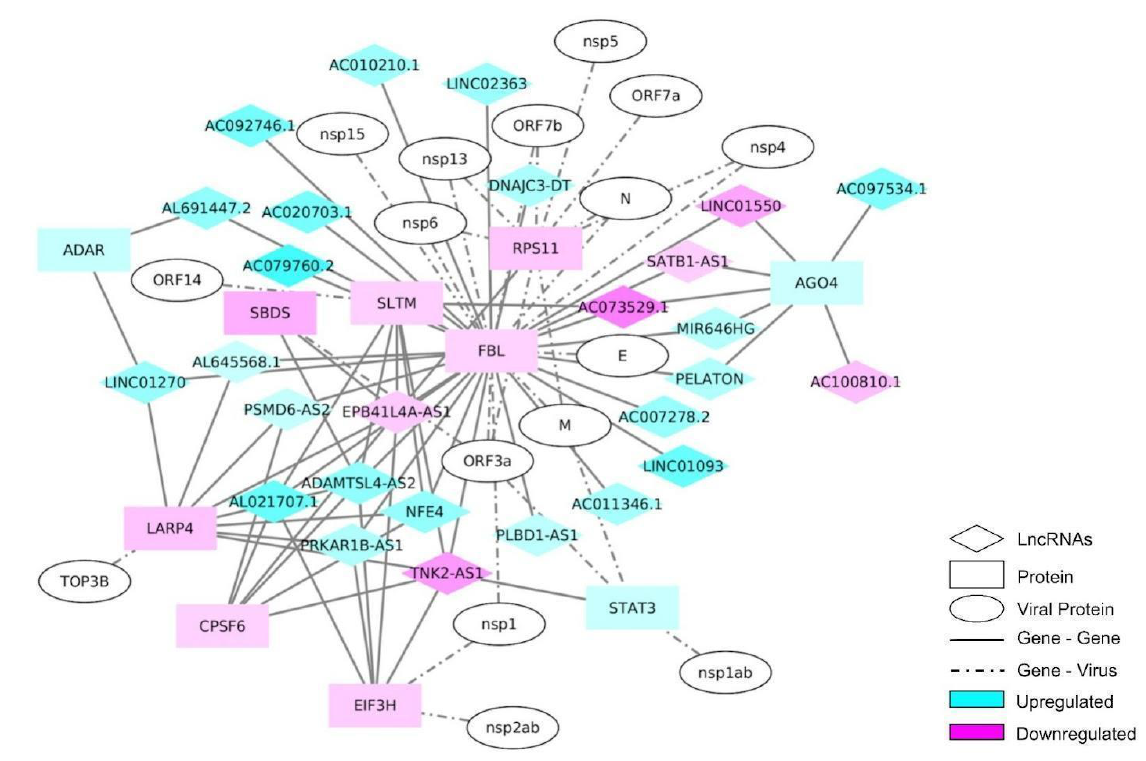
Figure 5. Interaction network of the most differentially expressed long non-coding RNAs (lncRNAs) and protein-coding genes, along with the SARS-CoV-2 proteins that interact with each one. An interaction network was constructed using an interactome tool with the differentially expressed lncR- NAs and protein-coding genes. The SARS-CoV-2 proteins were added using biomedical interaction repository (biogrid)